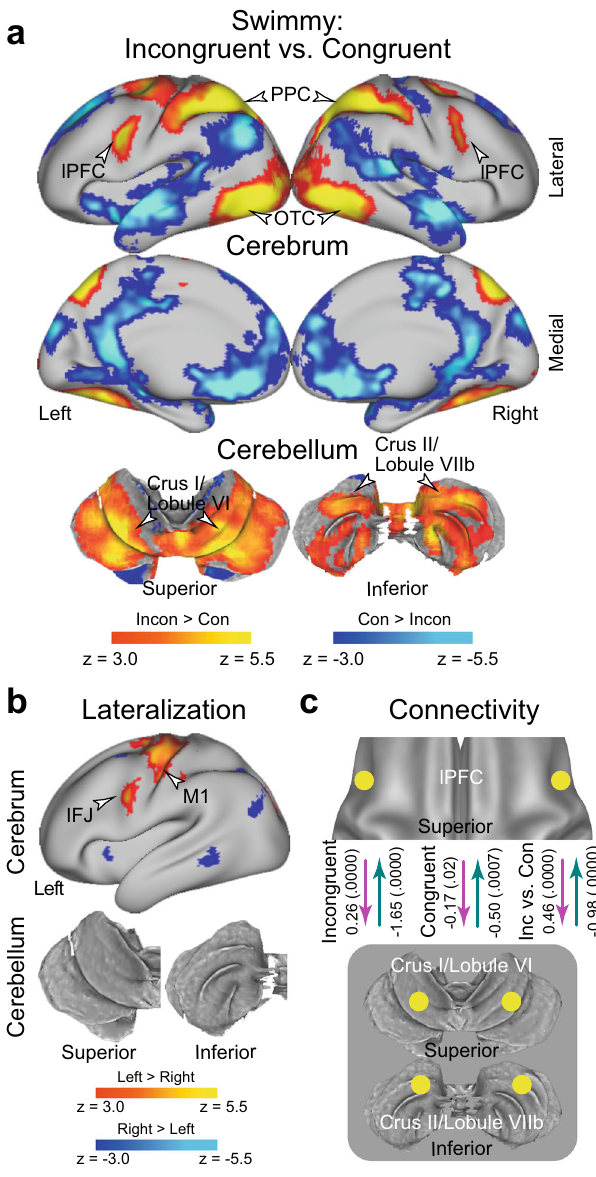
Fig. 4 | Non-verbal Swimmy effect involves a bilateral fronto-cerebellar loop during stimulus perception. a Statistical activation maps for signal increase and decrease in the contrast between incongruent and congruent trials in the Swimmy task. The vocal and manual conditions were collapsed. b Statistical maps of brain regionsshowingdifferentialSwimmyeffectactivation( a )betweentheleftandright hemispheres. IFJ inferiorfrontal junction. c Effective connectivity analysisbetween the lPFC and cerebellar regions based on dynamic causal modeling. The dashed arrows indicate insigni fi cant connectivity. Statistical procedures and formats are similar to those in Fig.